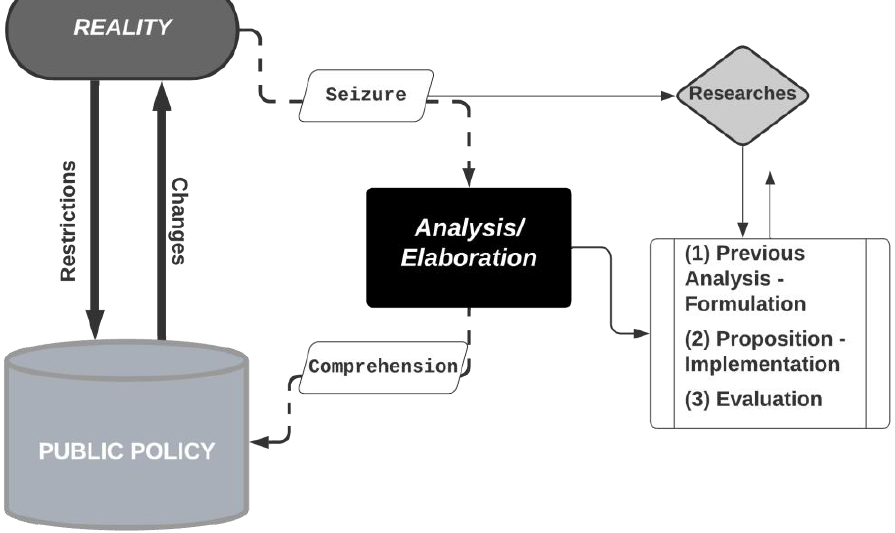
Figure 3. Process of analyzing public policies and steps for classifying articles.